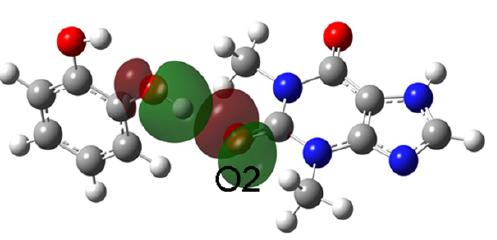
Figure 6. Natural bonding orbital interactions of the CAT-TEO 1 model cocrystal.